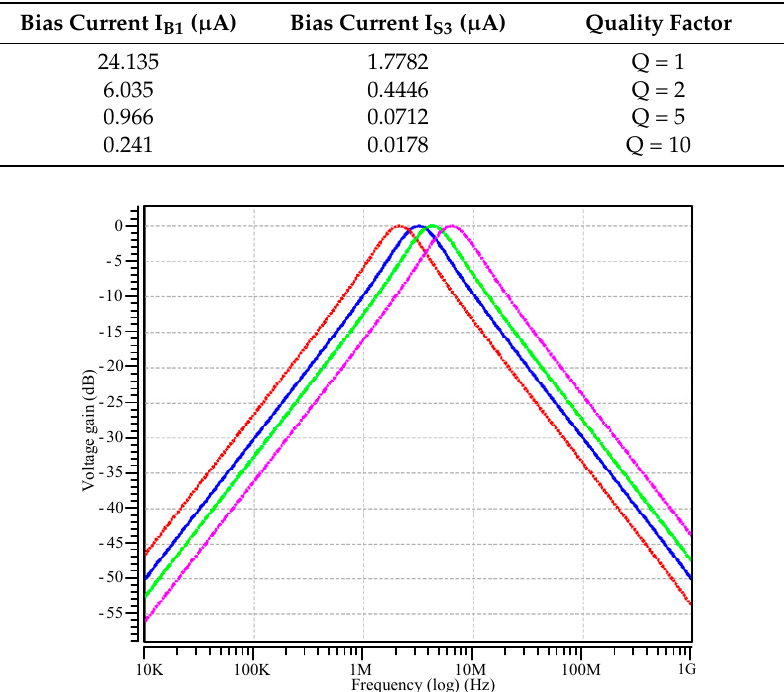
Figure 11. The VM bandpass filter at the output V o2 of Figure 2 when variation in f o with Q fixed at 1 (f o = 2.13 MHz: red; f o = 3.22 MHz: blue; f o = 4.32 MHz: green; and f o = 6.48 MHz: pink).